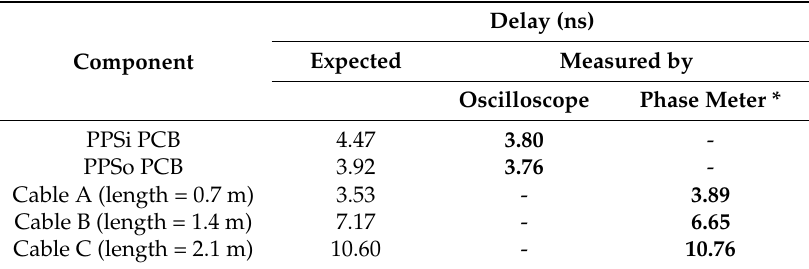
Table 3. Subsystems measured delays.